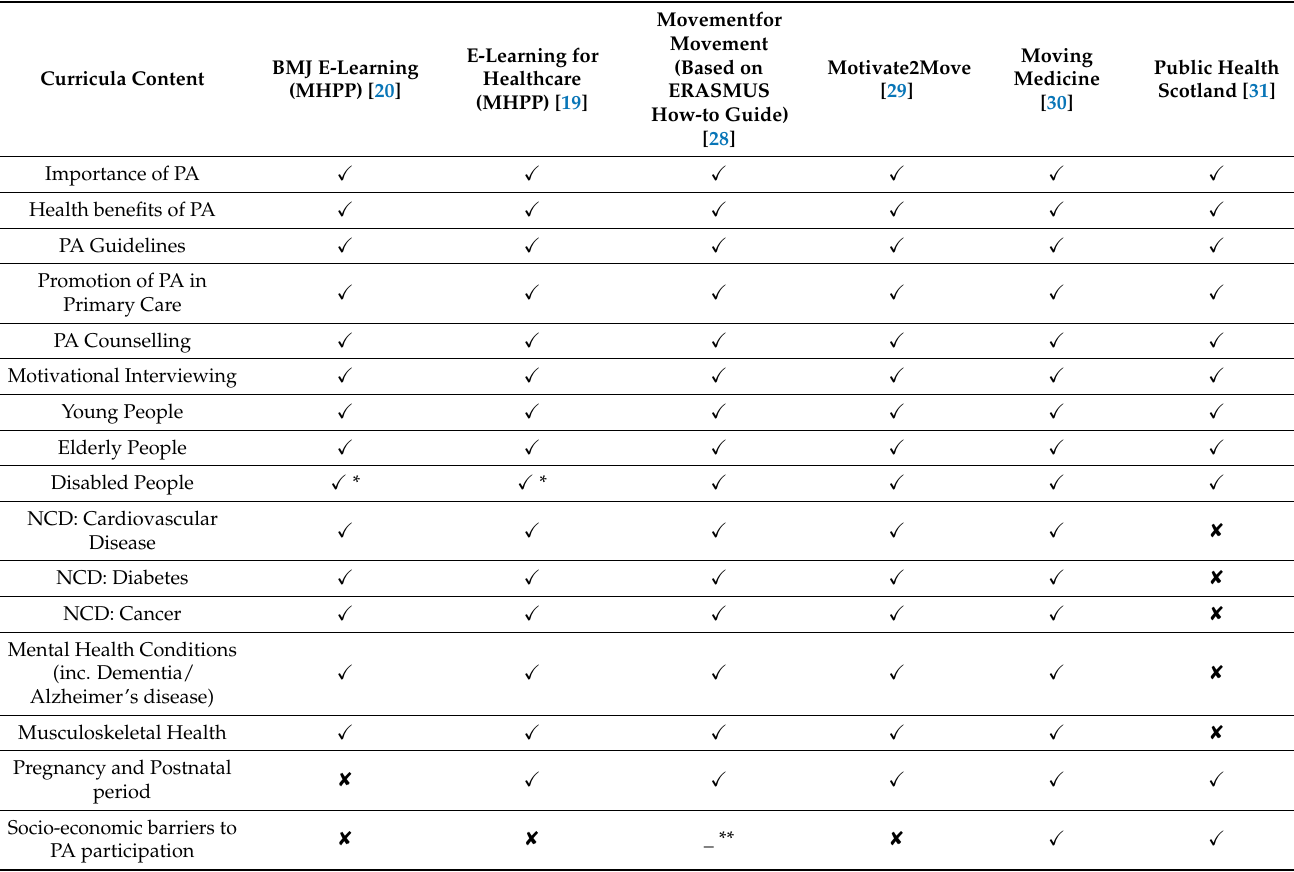
Table 2. E-learning and online training resources stated within included studies.